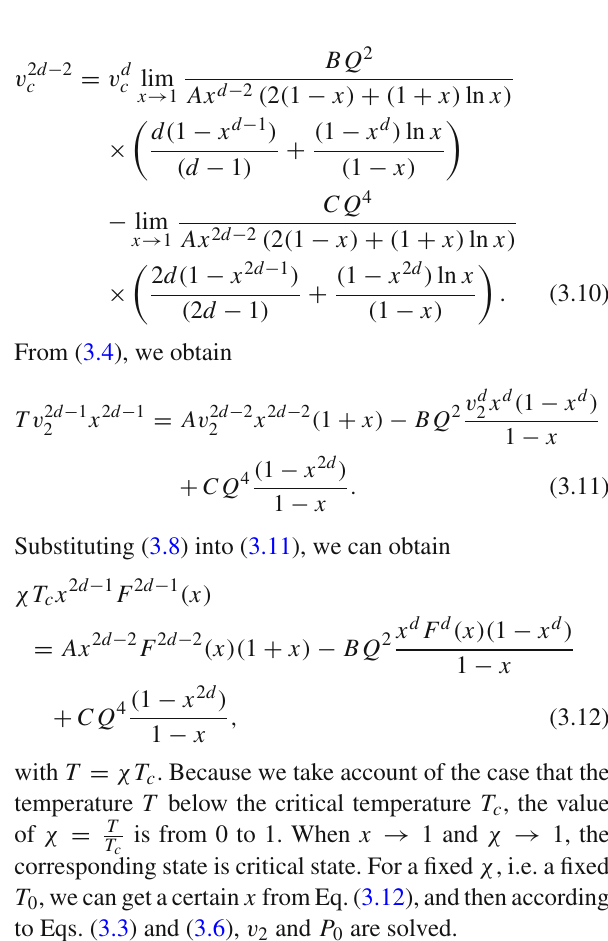
Fig. 2 The simulated isothermal phase transition by isobars and the boundary of two-phase coexistence region for the topological dilaton black hole as n = 5, b = 1 . 2, Q = 1 . 2, α = 1 √